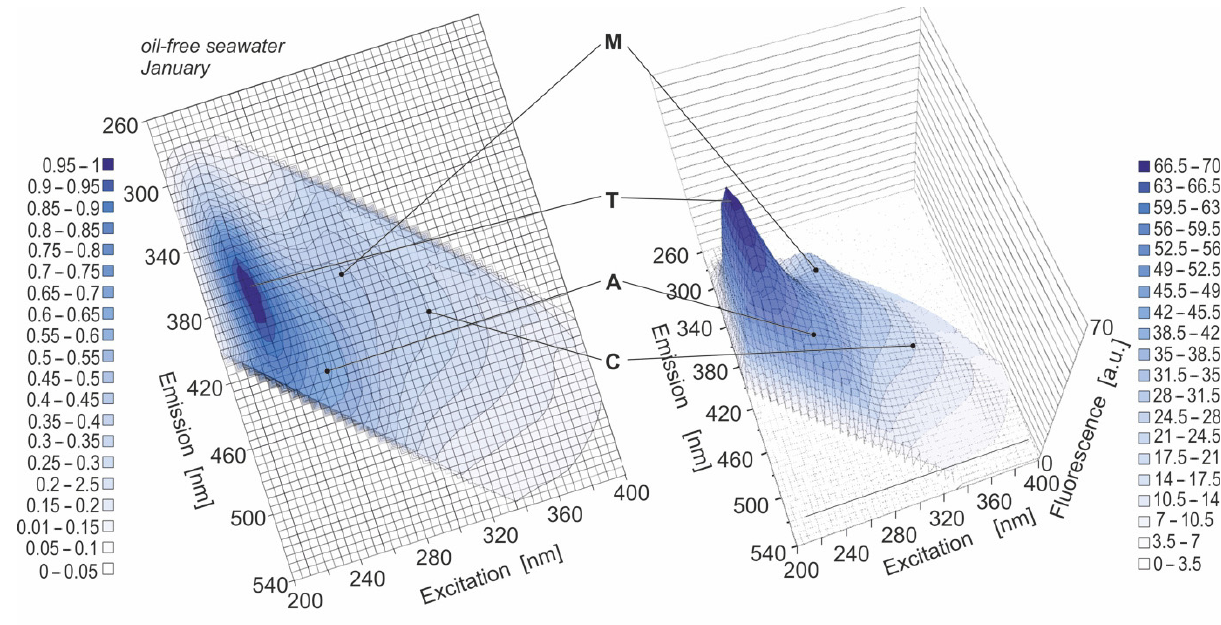
Figure 2. EEMs of oil-free seawater in 2D ( left side) and 3D ( right side) for the sample month of